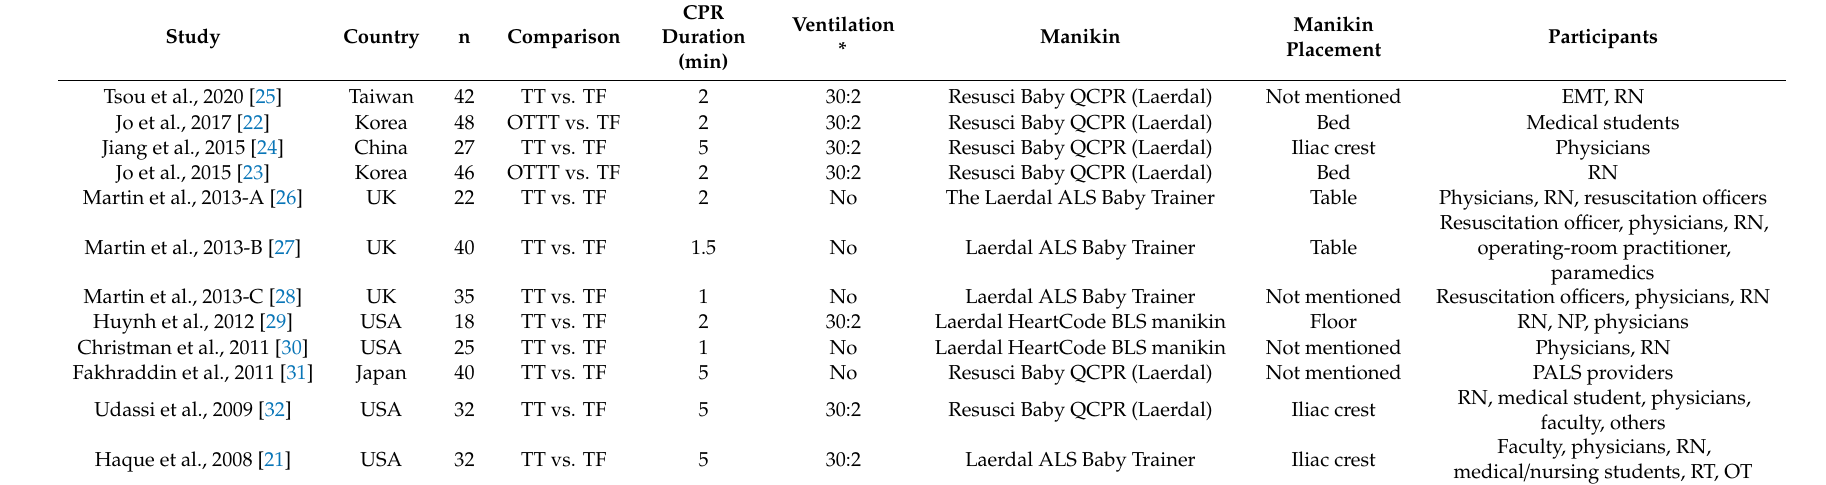
Table 1. Detailed characteristics of included